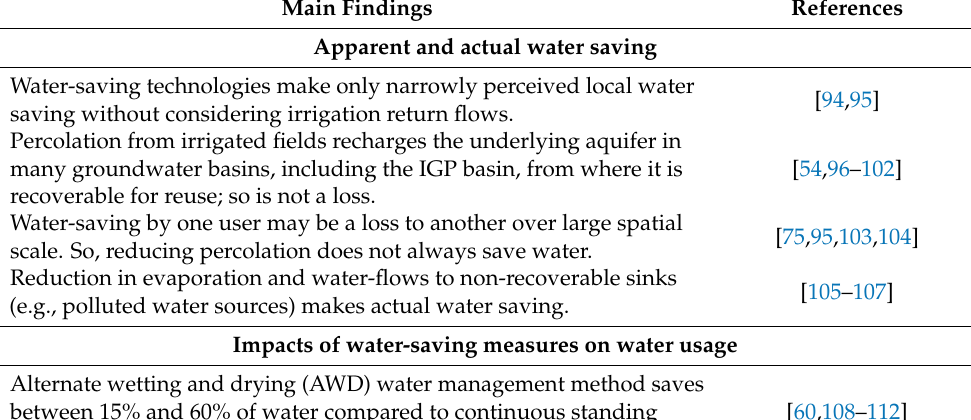
Table 1. Summary of major previous studies assessing the impacts of agricultural water-saving technologies on local and regional hydrology. The studies are grouped by apparent and actual water saving, impacts of water-saving measures on water usage and regional water balance, gaps in current knowledge in certainty and scale-effect of water saving, and policy formulation for water resources